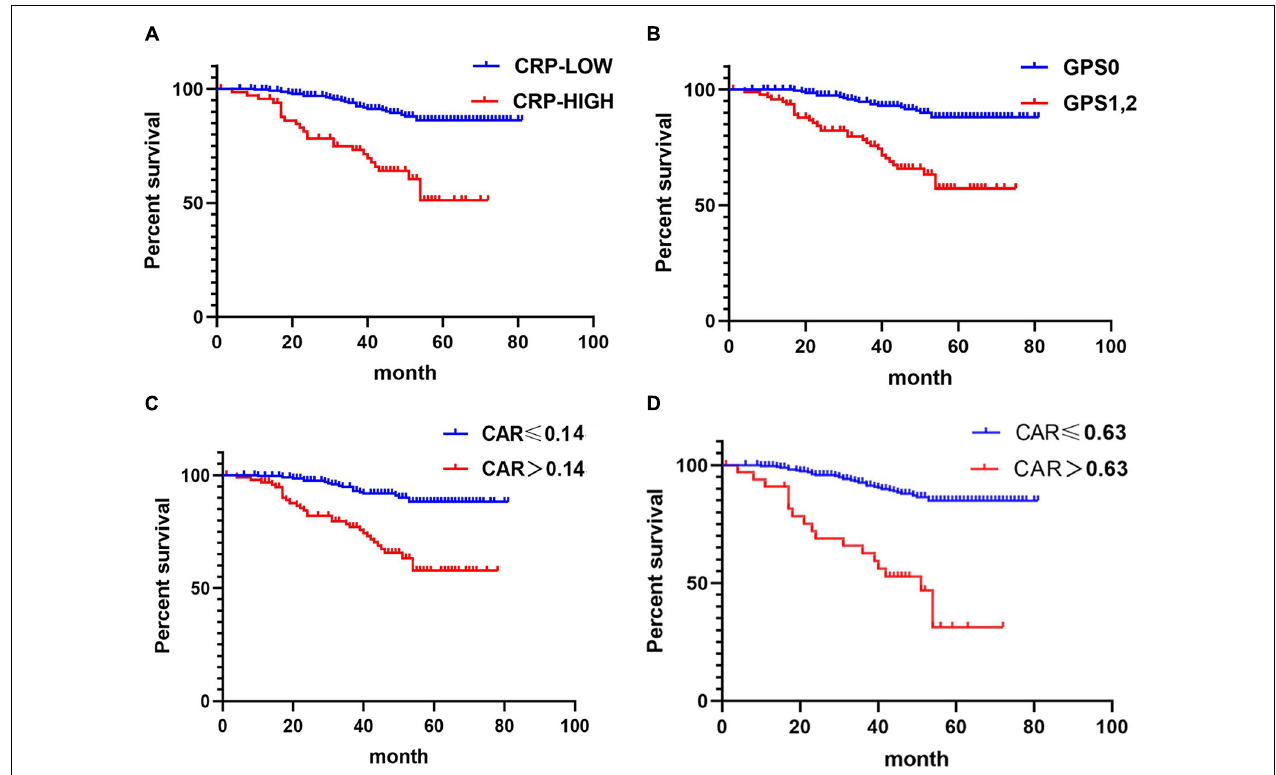
FIGURE 3 | Relationship between C-reactive protein (CRP), CRP-to-albumin ratio (CAR), and Glasgow Prognostic Score (GPS) and overall survival (OS) in patients undergoing surgery for stage I–III colorectal cancer (CRC). (A) Relationship between the two CRP groups and OS. (B) Relationship between the two GPS groups and OS. (C) Relationship between the two CAR groups and OS. CAR was analyzed by grouping based on the cutoff value of the receiver operating characteristic (ROC) analysis in Figure 2B . (D) Relationship between the two CAR groups and OS. The optimal cutoff levels for CAR were produced using the X-tile plot in Supplementary Figure 1B